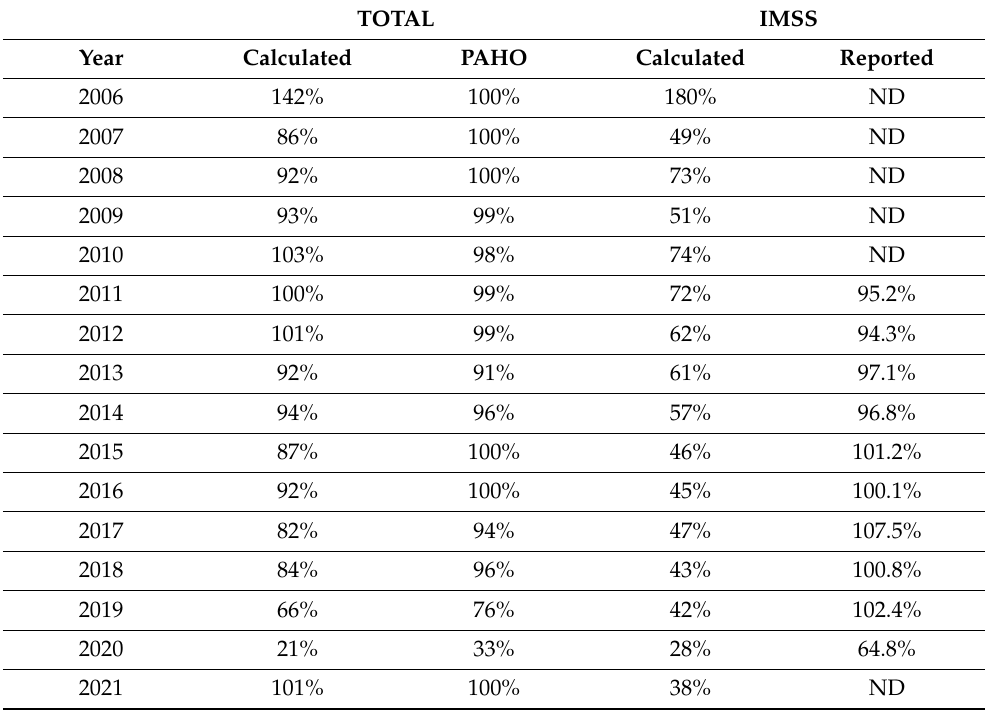
Table 5. Coverage: comparison with total values and those reported by